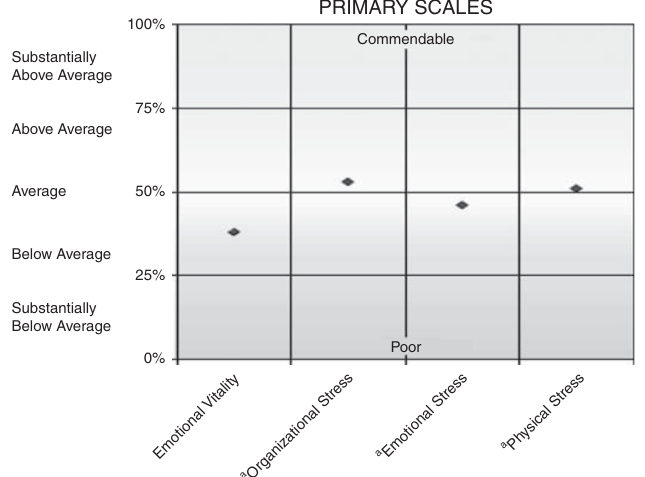
Figure 9. Organizational